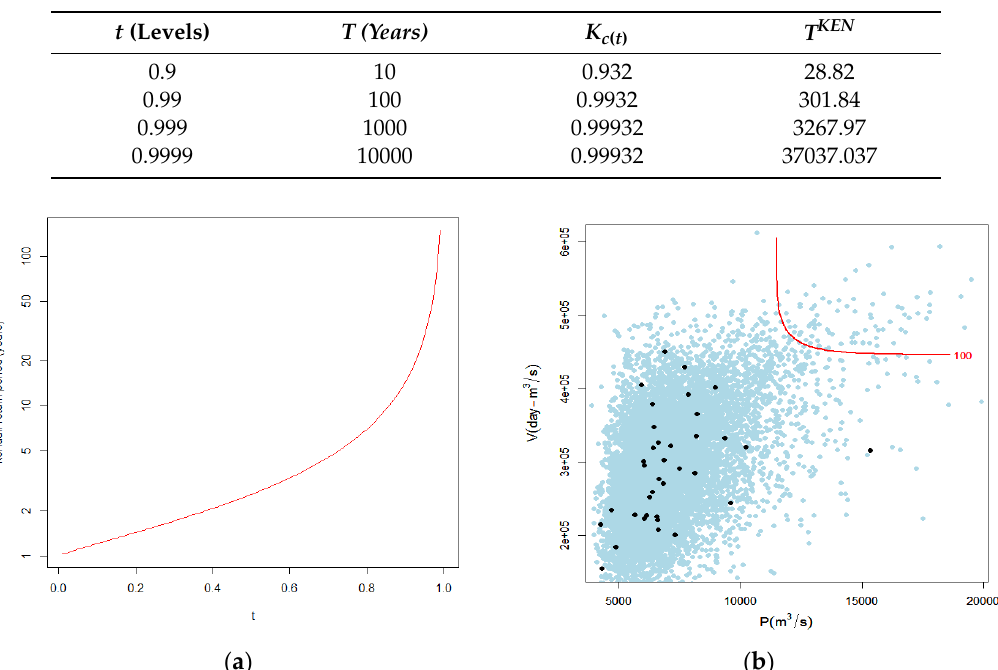
Table 8. Kendall return period for different t values.